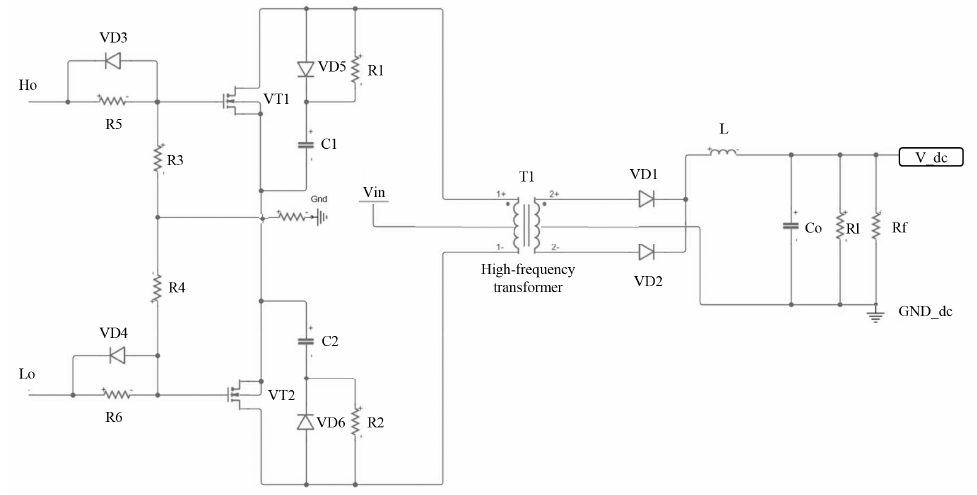
Figure 3. Schematic diagram of the push-pull direct current (DC) conversion circuit. Figure 3 . Schematic diagram of the push-pull direct current (DC) conversion circuit.